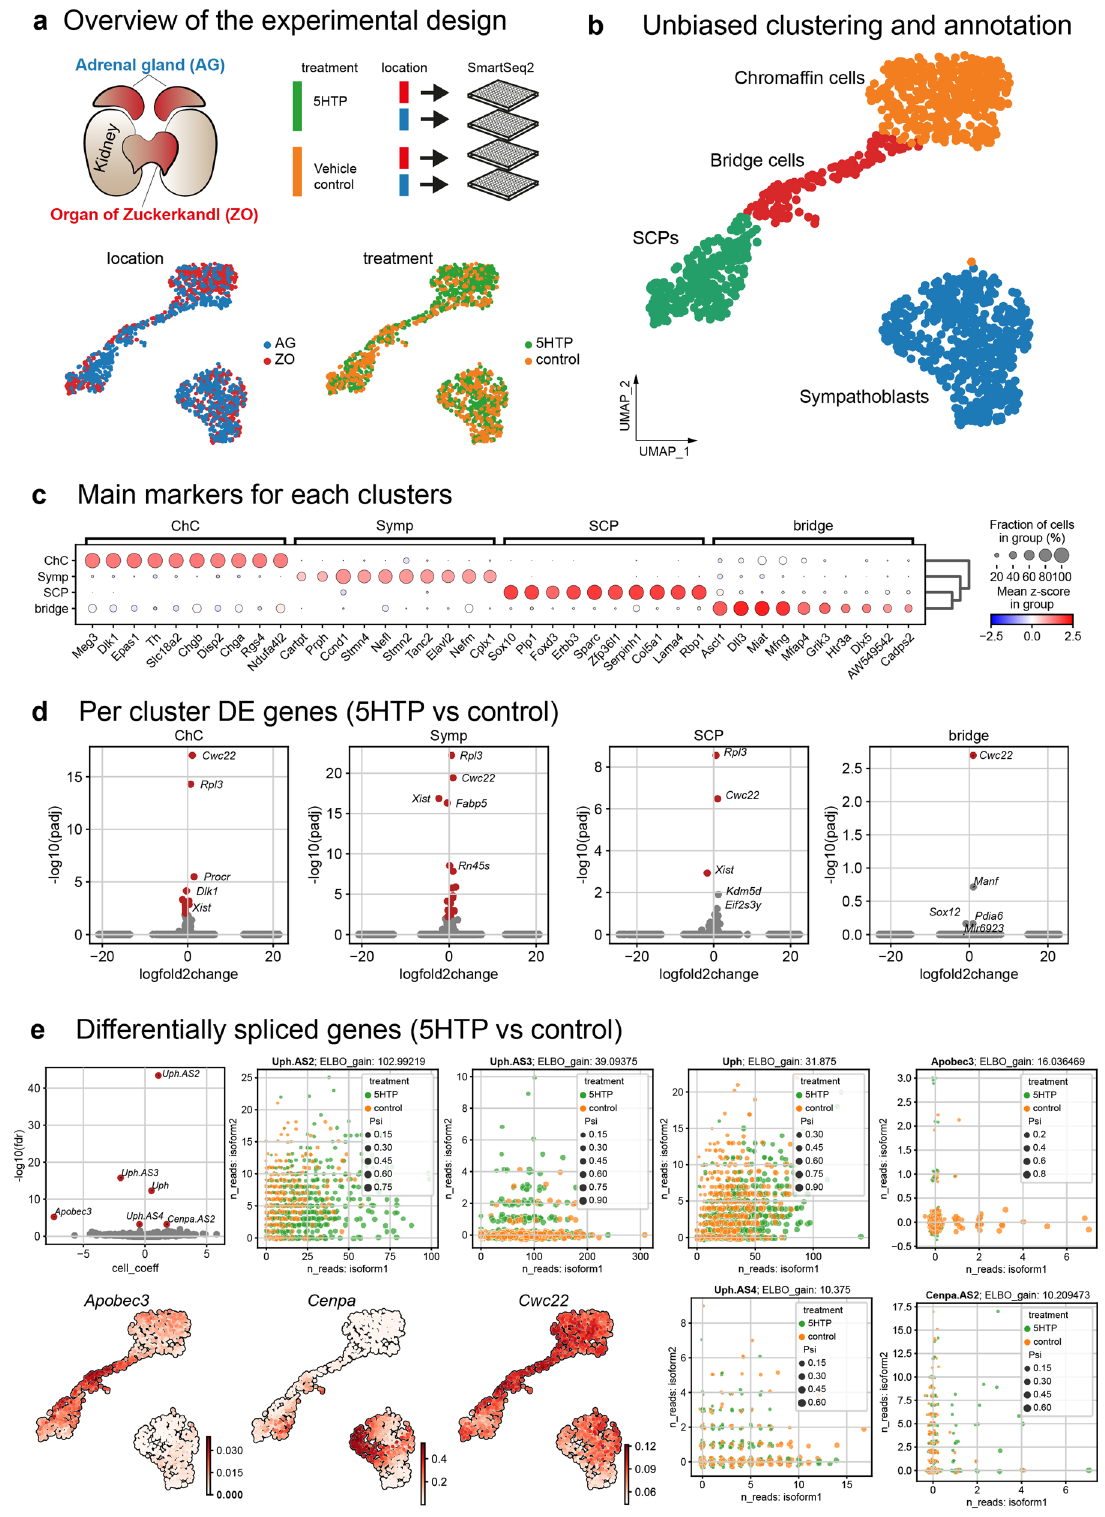
Here we investigated how these intermediate cell types regulate their numbers and de fi ne the future size of the chromaf fi n population. We found that 32% of the chromaf fi n cells are 5HT positive as soon as they emerge at E12.5 in mouse and this number goes up to 77.8% at E14.5. The 5HT, which is derived from chromaf fi n cells and a small population of “ bridge ” cells, signals to neighboring HTR3A + “ bridge ” cells, lengthening their